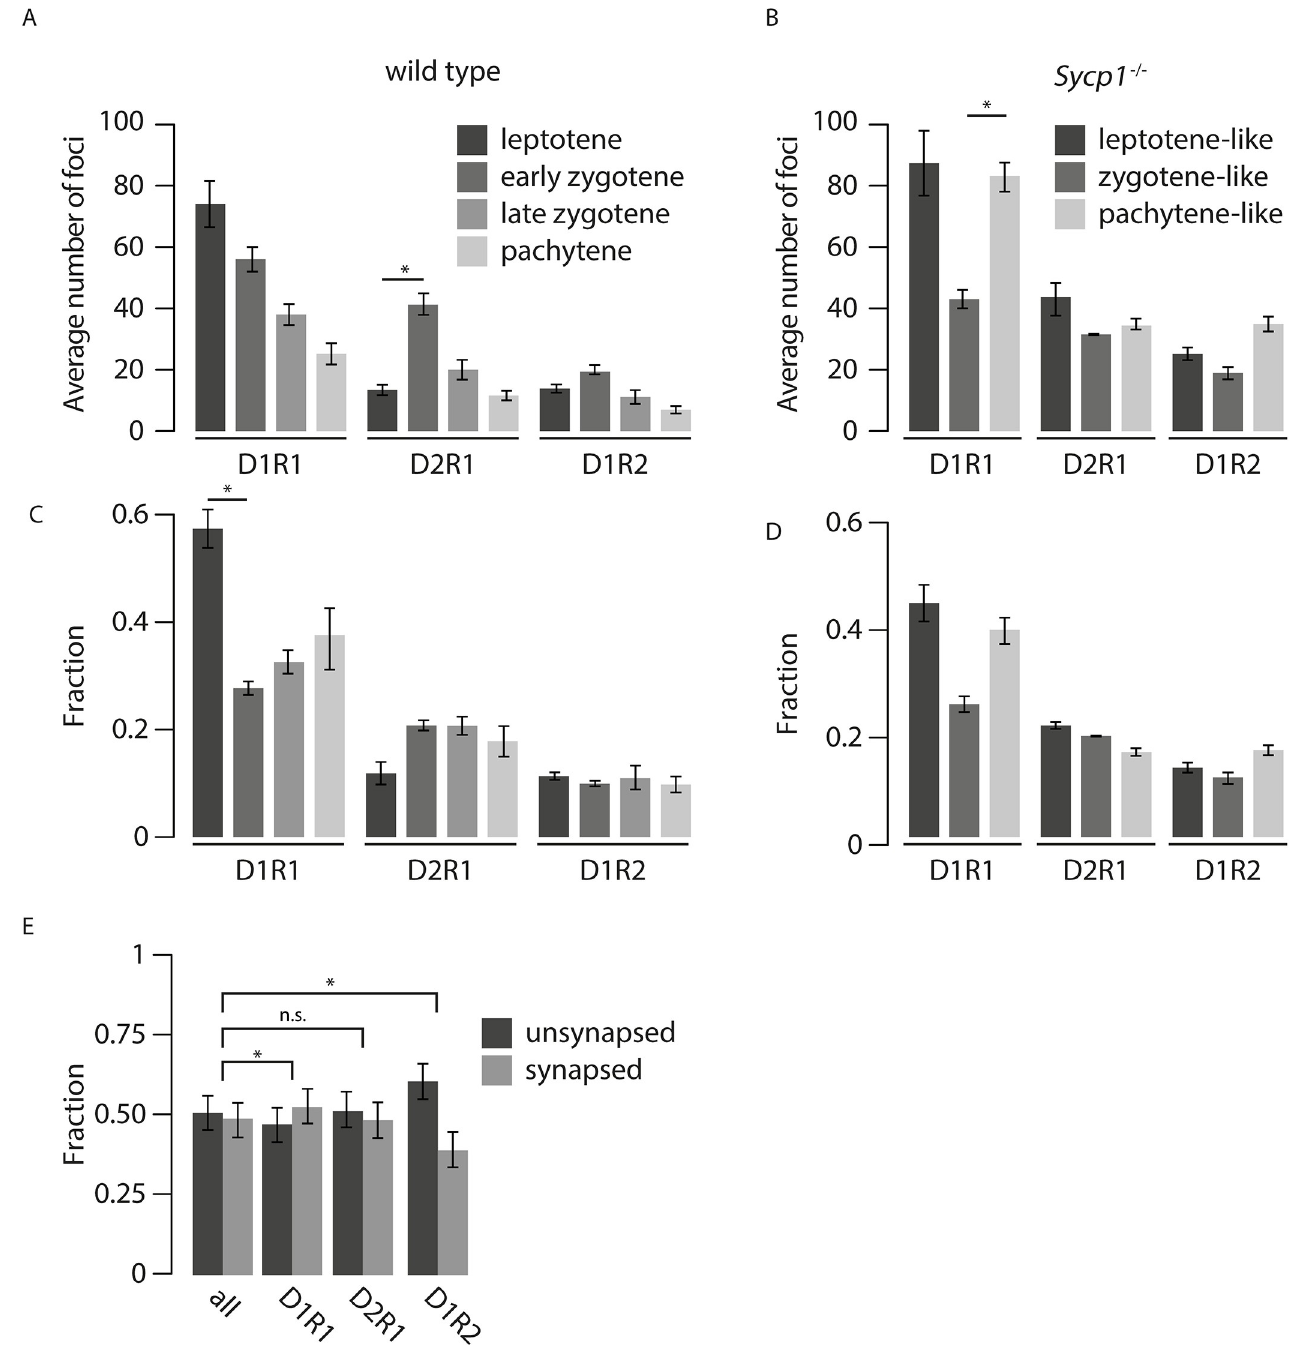
Fig 4. Dynamics of D1R1, D2R1, and D1R2 foci numbers during progression of meiotic prophase in wild type and Sycp1 -/- spermatocytes. Average number (A,B) and fraction (C,D) of D1R1, D2R1, and D1R2 foci per cell per stage for wild type (A, C) and Sycp1 -/- (B, D) spermatocytes. E) Fraction (right) of all foci, compared to the fraction of D1R1, D2R1 and D1R2 foci on synapsed or unsynapsed synaptonemal complexes, per nucleus at the zygotene stage. Error bars indicate SEM, p-values can be found in S2 Table. D1R1 foci (Fig 5C, S2 Table), and the same was observed for the large DMC1 nanofocus in the D2R1 configuration. In addition, the far-DMC1 nanofocus in the D2R1 displayed a small but